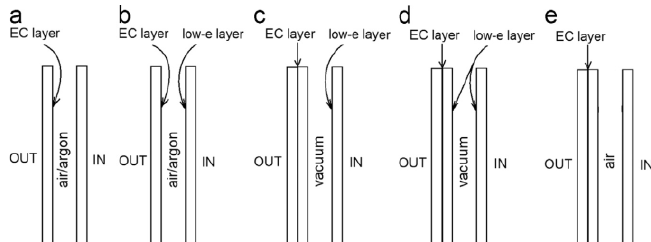
Figure 7. Layouts of different configuration of glazed panes hosting EC devices and low-e layers. ( a ) EC layer on Face 2 of a double glazed unit; ( b ) EC layer on Face 2 and low-e layer on Face 3 in a of a double glazed unit; ( c ) double glazed unit embodying an external laminated glazing containing EC layer and a low-e layer on Face 3; ( d ) laminated glazing containing EC layer and low-e layer on both faces of the vacuum interspace; ( e ) double glazed unit with EC layer in a laminated glazing.